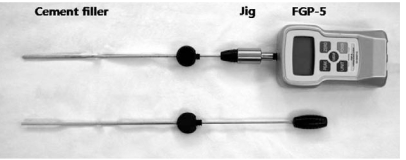
Methods for measuring the pressure-related manipulation time. A cement filler with a 2.8 mm diameter was connected to FGP-5. A jig can hold a cement filler tightly along the parallel axis to FGP-5 to prevent unexpected resistant pressure during cement-pushing.